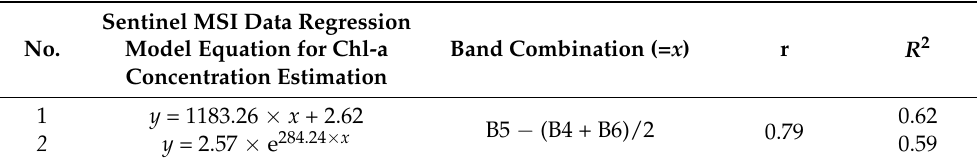
Table 7. Regression model for the retrieval of Chl-a concentration using Sentinel MSI training datasets.